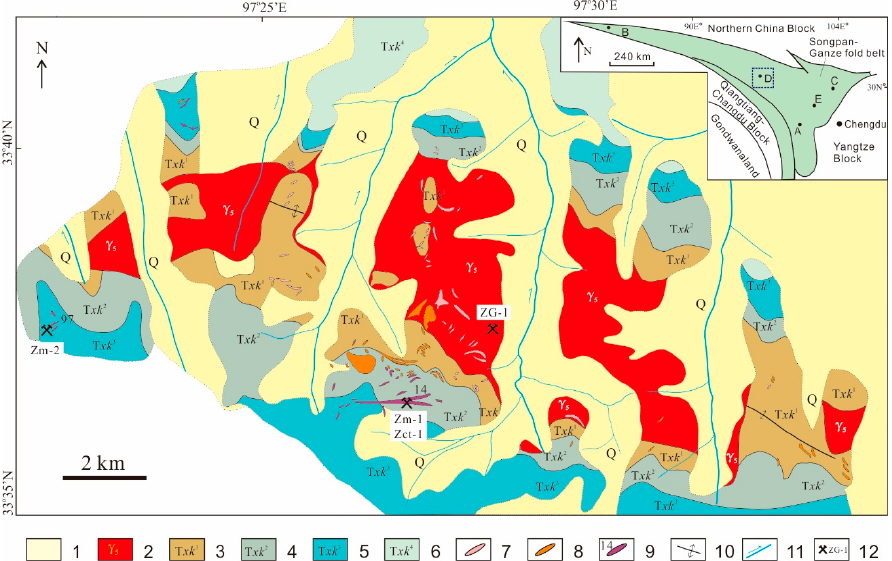
Figure 5. Geological map of the Zhawulong Li–Be–Nb–Ta deposit in Xinjiang, China. 1: Quaternary sediment; 2: Muscovite granite; 3: Biotite quartz quartzite and biotite granulite with transgranular pyroxene kernels; 4: Biotite quartz (staurolite or andalusite) schist; 5: Biotite granulite, biotite quartz schist; 6: Phyllite rock metamorphism sandstone and metamorphic shale; 7: Microcline pegmatite; 8: Microcline feldspar pegmatite; 9: Albite–spodumene pegmatite and number; 10: Anticline axis; 11: River and flow direction; 12: Sampling location with sample number in Table 1. The legend for the diagram in the upper right-hand corner is provided in Figure 1.